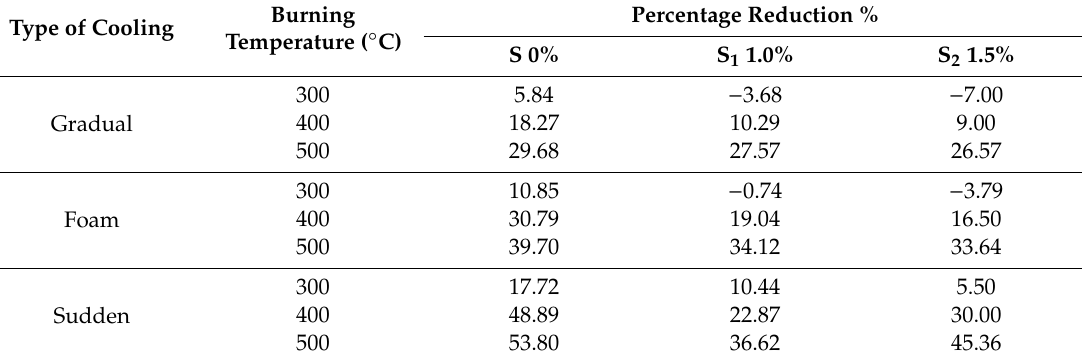
Table 12. Flexural strength percentage reduction concerning all types of cooling for the adopted (RPC)